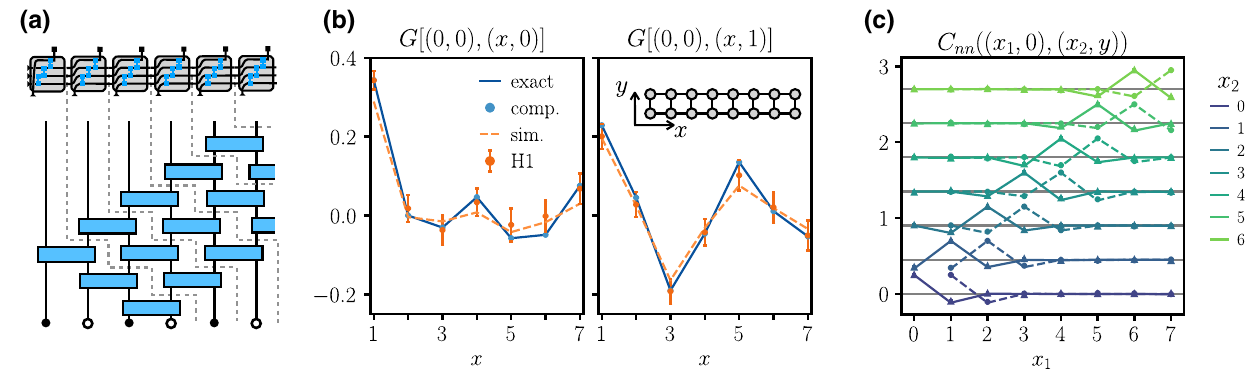
FIG. 1. Compressing Gaussian fermion states as QMPS—(a) holographic QMPS implementation (top) of the GMPS circuit (bot- tom) for approximately preparing compressed Gaussian fermion states. (b)–(c) Experimental implementation of holographic GMPS algorithm for a spinless two-leg ladder at half-filling. (b) (Real part of) Green’s function, Re G imental data (orange dots with 1 σ error bars from 1000 measurement shots per point), noisy circuit simulations with one-qubit and two-qubit gate depolarizing parameters p 1 q = 10 − 3 and p 2 q = 5 × 10 − 3 , respectively (dashed orange line), and exact values (solid blue line). (c) Connected part of density-density correlators C nn ( r , r (cid:6) ) with r = ( x 1 , 0 ) and r (cid:6) = ( x 2 , y ) , with y = 0 data shown as solid lines (theory) and triangles (experiment), and y = 1 data shown as dashed lines (theory) and circles (experiment), respectively. Each point represents 5600 measurement shots. Statistical error bars in (c) are included, but smaller than plot